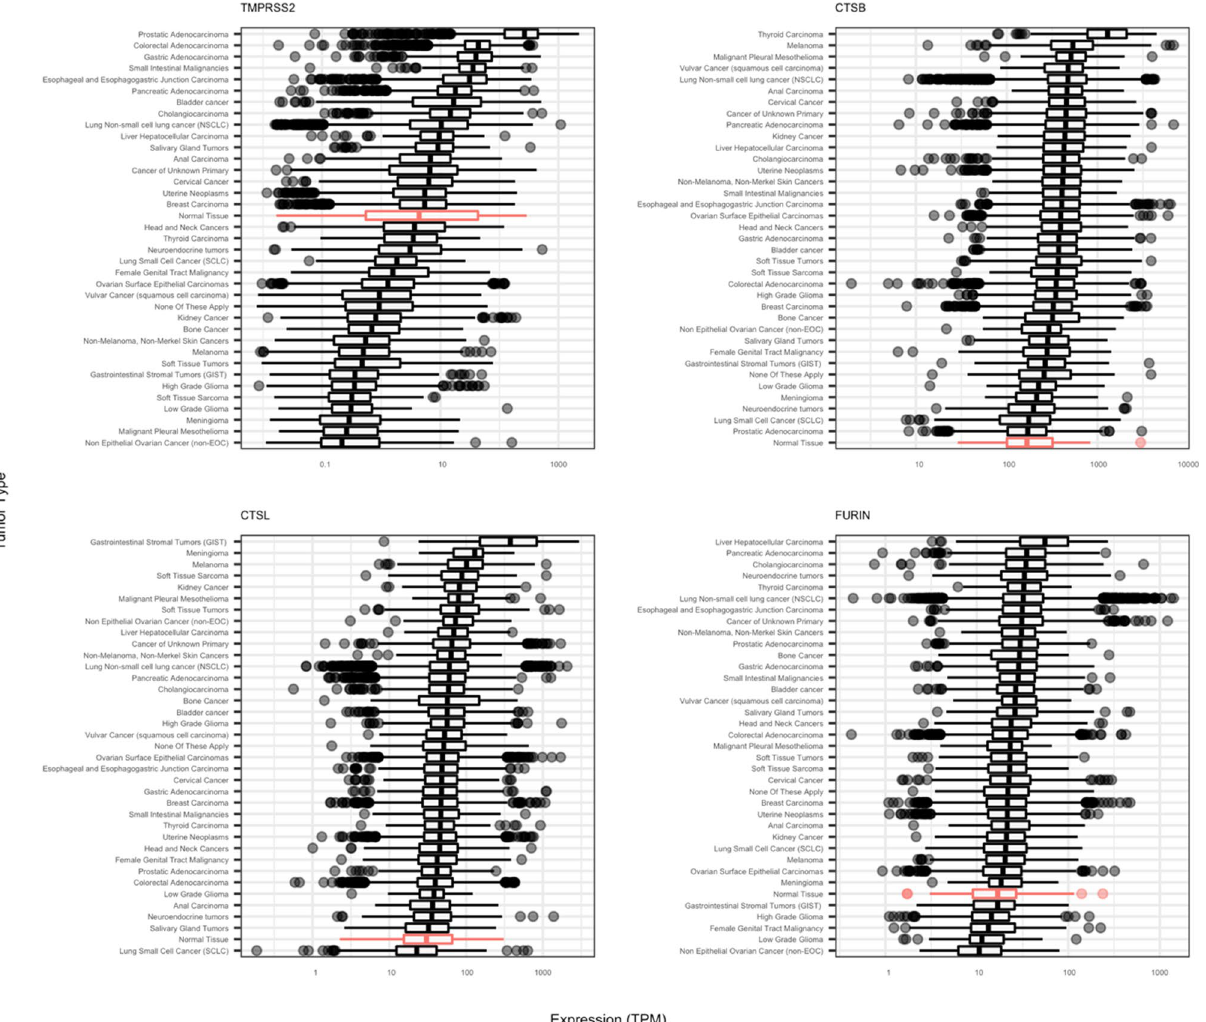
Figure 2. Protease gene expression in normal and cancerous tissues. Box plots indicate the median and upper/ lower quartiles, with individual data points representing outlier values greater than 1.5 × the interquartile range above or below the upper or lower quartile,